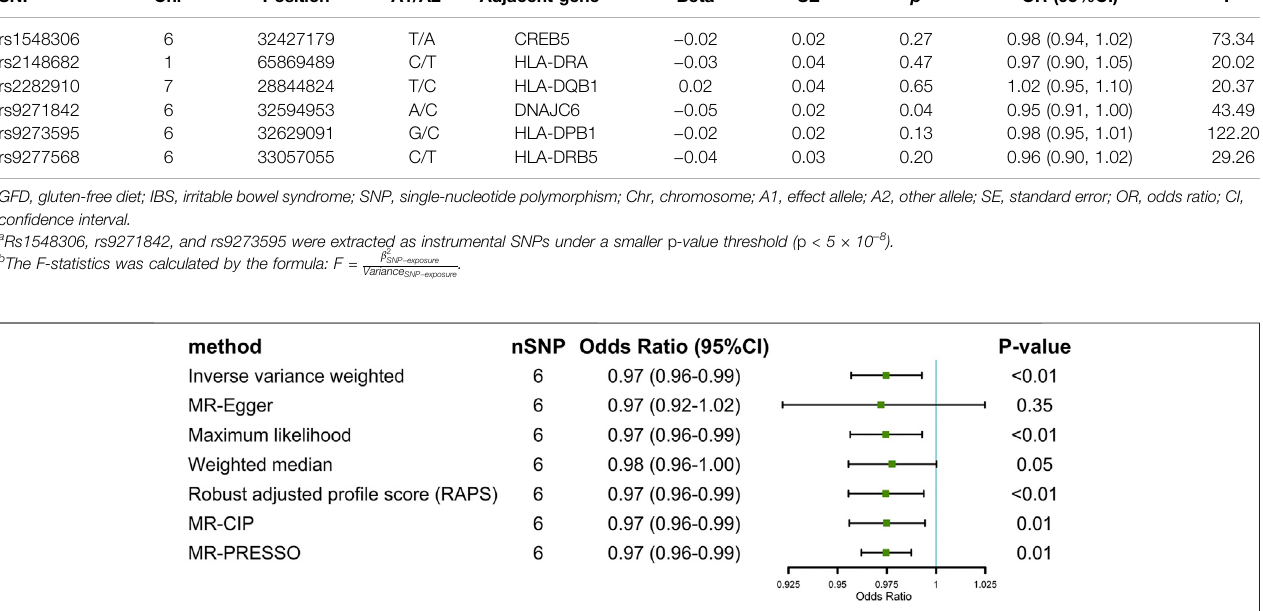
Frontiers in Genetics |